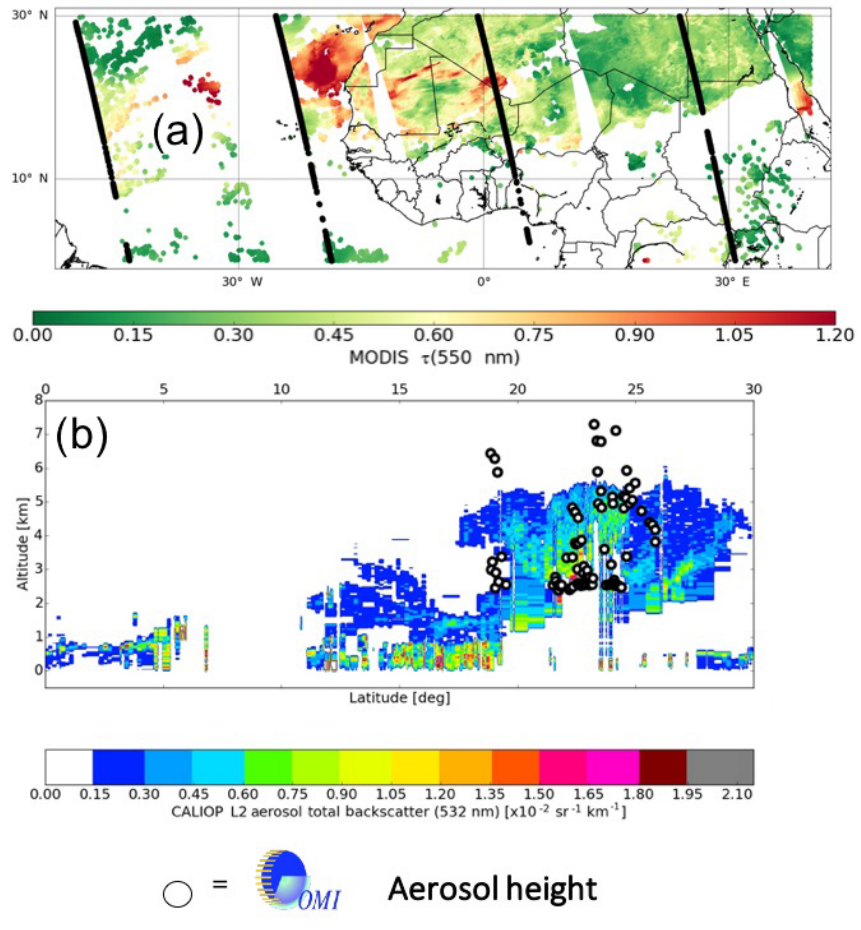
Figure 9. Elevated layer due to a Saharan dust outbreak transported to western Mediterranean region over sea on 19 July 2007. (a) Map of Aqua MODIS τ( 550nm ) from the combined DT and DB Collection 6 (see Sect. 2.3). (b) Retrieved OMI ALH compared with vertical profile of aerosol total backscatter coefficient (532nm) from the CALIOP L2 aerosol total backscatter (532nm) associated with the second left CALIPSO track over sea in Fig.